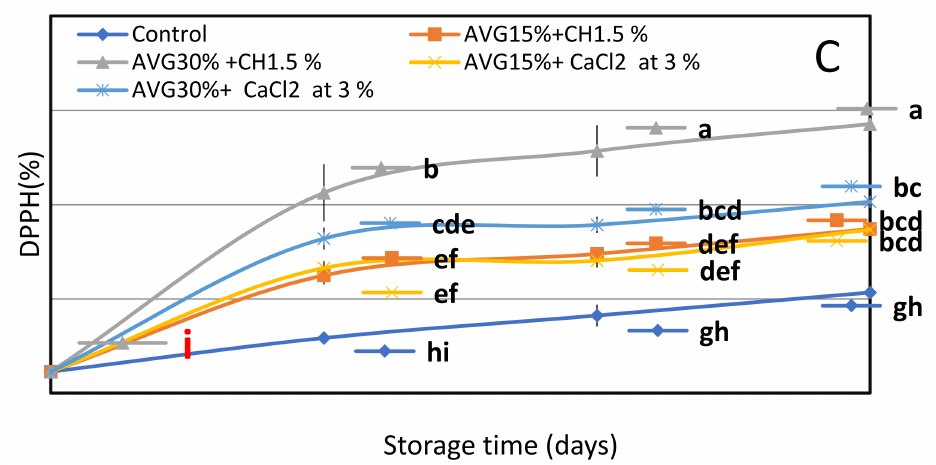
Figure 3. The effect of coating with AVG at 15 and 30% mixed with CH at 1.5% or CaCl 2 at 3% on H 2 O 2 mmole min − 1 · g − 1 FW ( A ), O 2 •− mmole min − 1 g − 1 FW ( B ), and DPPH % ( C ) of ‘sultany’ peaches during cold storing at 3 ± 1 ◦ C and 95 ± 1% RH for 36 days. The SE ( ± SE of n = 3) is shown by the vertical bars and the alphabetical letters indicated the importance at p ≤ 0.05 among treatments in each storing period. The average of both trial seasons (2020 and 2021) was analyzed by using Duncan’s Multiple Range Test. p -value of H 2 O 2 , F1 = 0.009 F2 = 0.011 F1 × F2 = 0.020, O 2 •− , F1 = 0.010 F2 = 0.011 F1 × F2 = 0.023 and DPPH, F1 = 0.84 F2 = 0.94 F1 × F2 = 1.93.